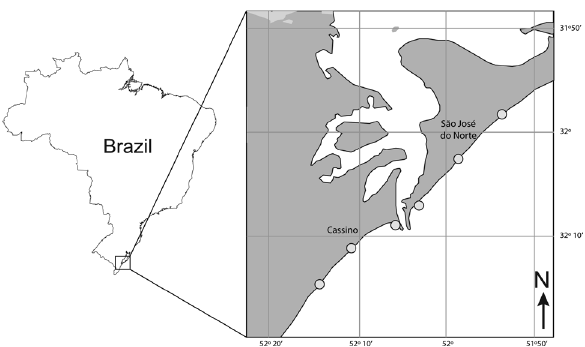
Figure 1. Location of the six sampling sites in the coastline of Rio Grande do Sul,